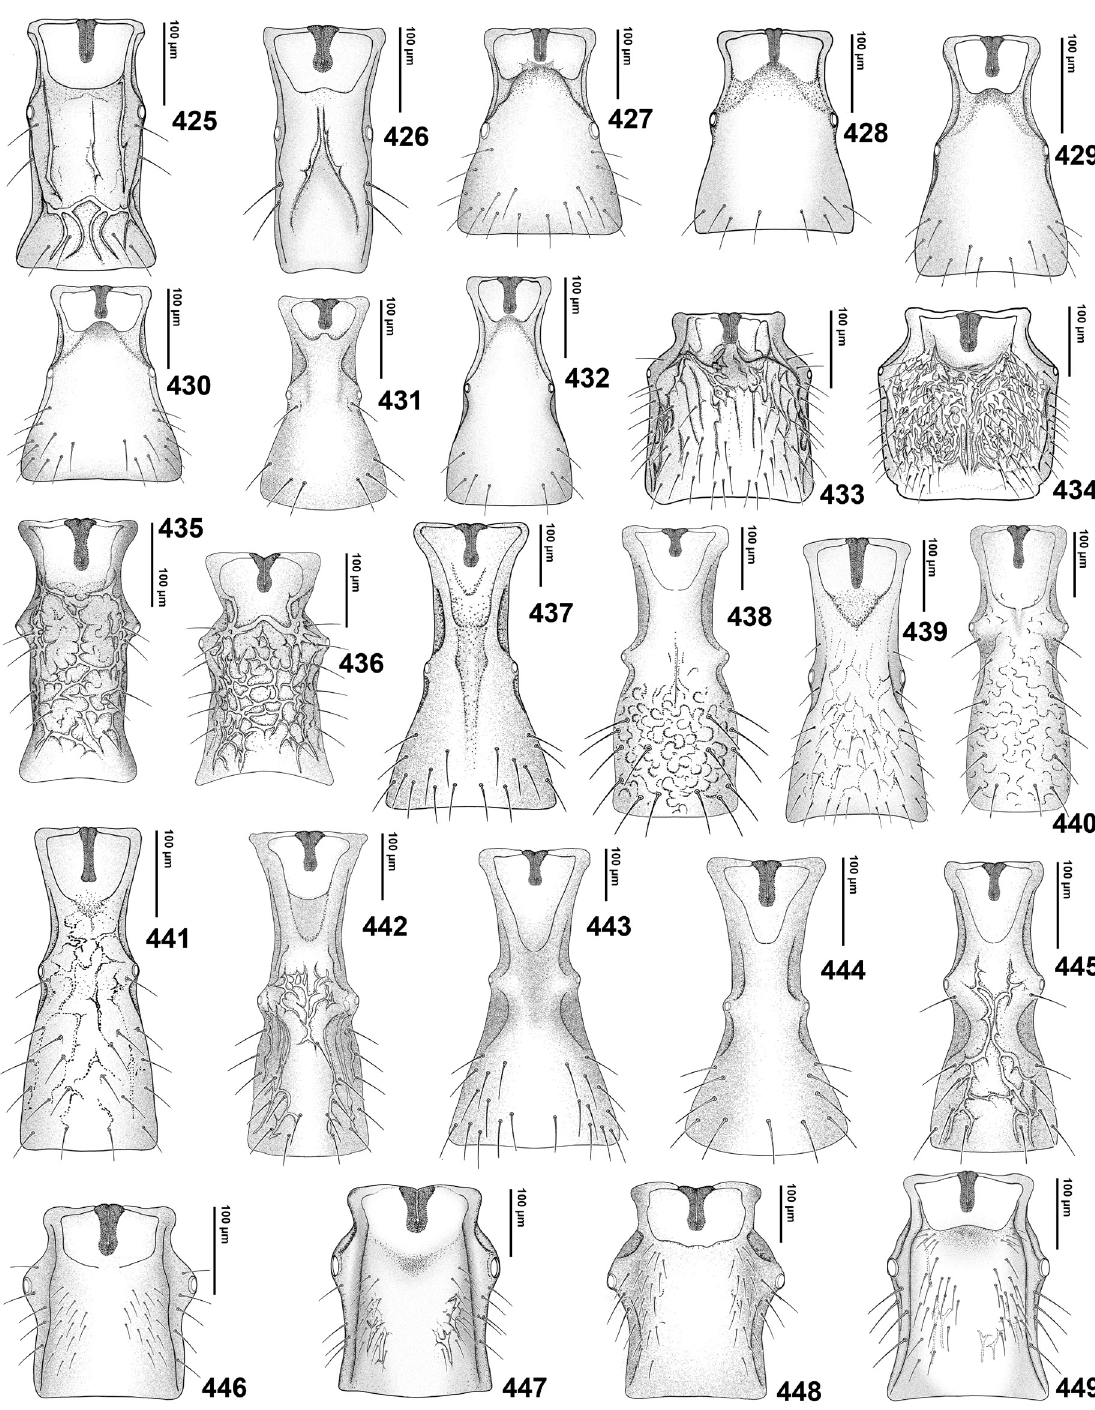
Figs 425–449. Dorsal aspect of petiole (♀): 425 . Ephedrus plagiator . 426 . Lipolexis gracilis . 427 . Lysiphlebus cardui . 428 . Lysiphlebus confusus . 429 . Lysiphlebus desertorum . 430 . Lysiphlebus fabarum . 431 . Lysiphlebus fritzmuelleri . 432 . Lysiphlebus testaceipes . 433 . Monoctonia pistaciaecola